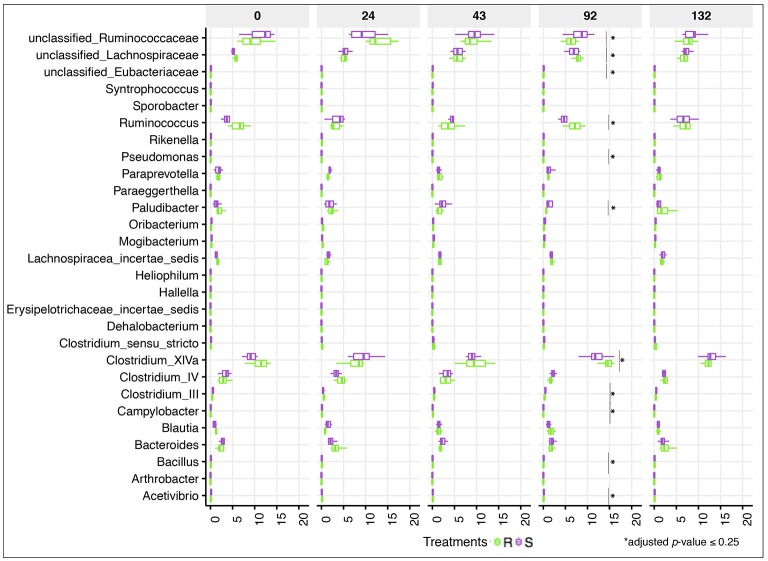
Dynamics of gut bacterial genera between susceptible and resistant animals across time. Boxplot graph representation of genera significantly affected between susceptible (S) and resistant (R) animals across time. In all cases, S animals are colored in purple and R animals in green. Boxes show median and interquartile range, and whiskers indicate 5th to 95th percentile. *Adjusted p ≤ 0.25 for comparison between S and R ponies in each time point. Bacterial genera without *are significant at a nominal p < 0.05.